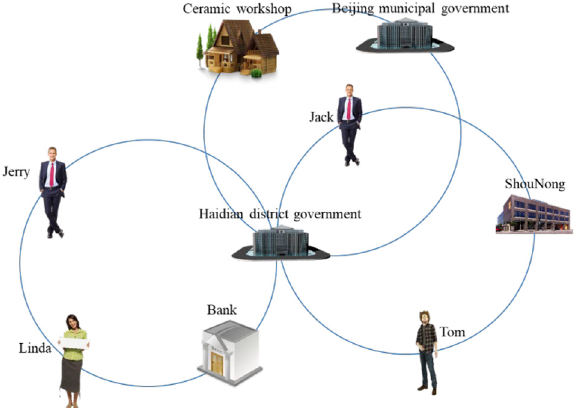
Figure 1. Topological Structure of the crowd transaction